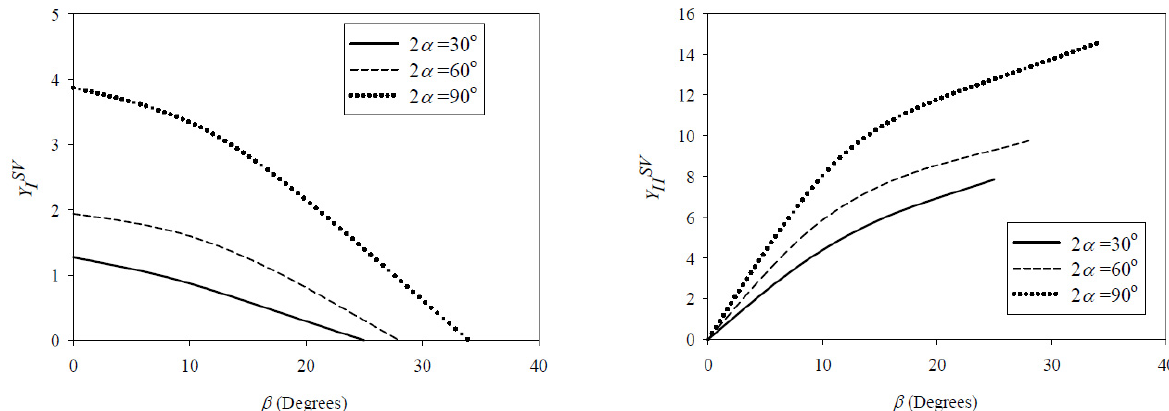
Figure 5. Variations of Y ISV and Y IISV vs. loading angle for SVNBD samples [23]. Table 2. Eigenvalues λ 1 and λ 2 , dimensionless parameters 𝑌 (cid:3010)(cid:3020)(cid:3023) and 𝑌 (cid:3010)(cid:3010)(cid:3020)(cid:3023) , and the values of param- eters 𝐾 𝐼𝑓 𝑆𝑉 and 𝐾 𝐼𝐼𝑓 𝑆𝑉 for tested SVNBD samples.